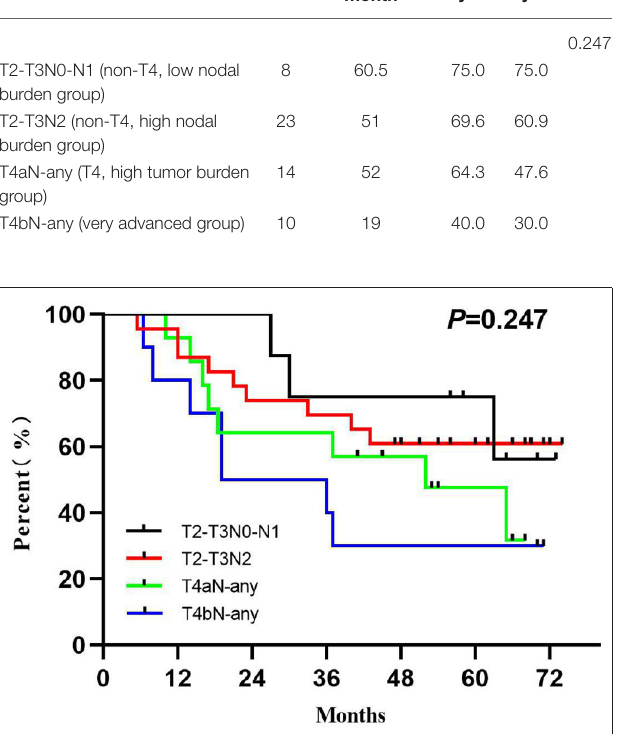
FIGURE 3 | Overall survival by tumor